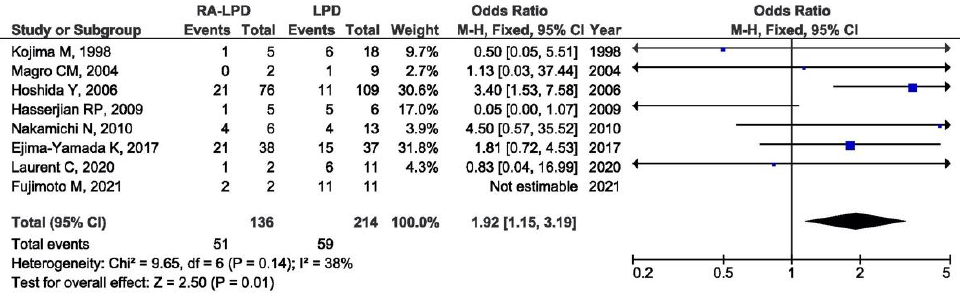
Figure 4. Meta-analysis of the difference in the positive EBV result in RA-LPD and LPD patients (blue dot represent the odds ratio and black frame 95% CI of the odds ratio from each of the included studies. black arrows show that upper and/or lower limit of the 95%CI of odds ratio is below or above defined values on the x